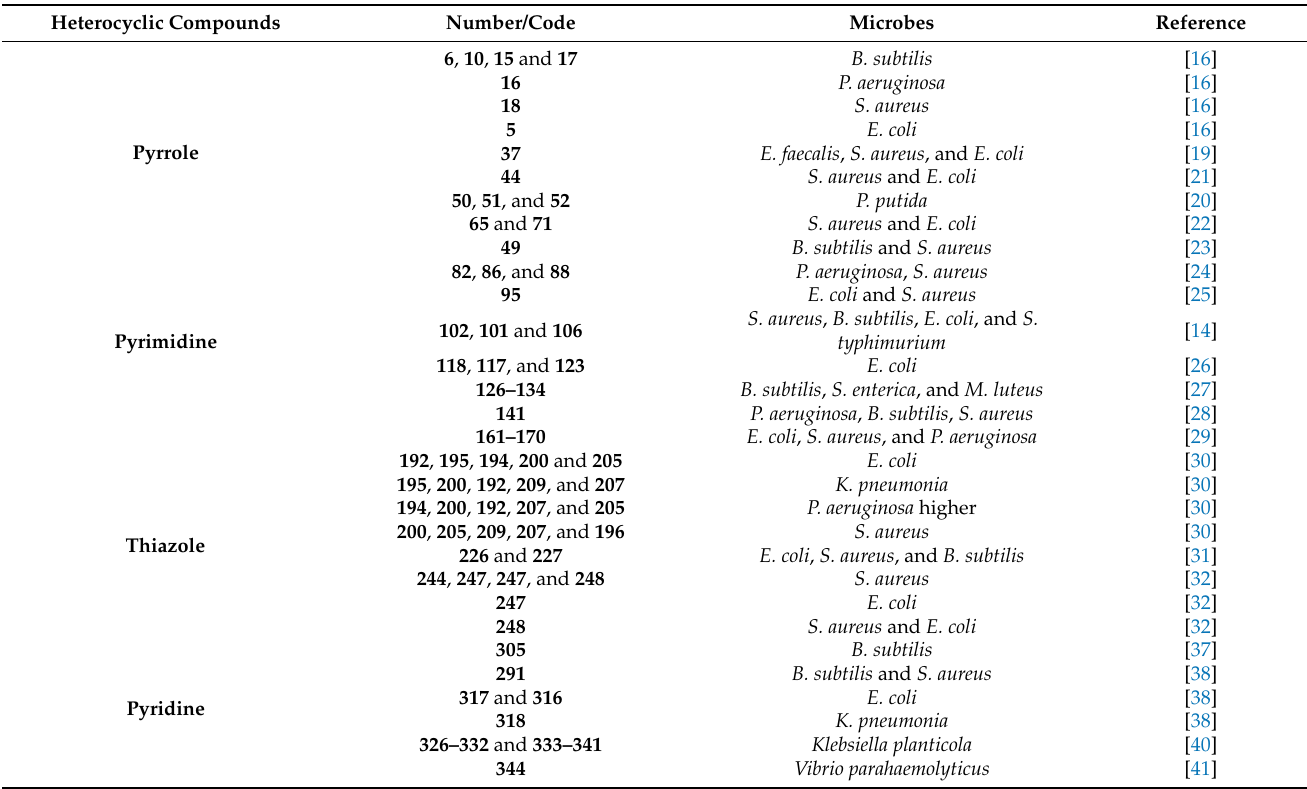
Table 1. Compounds with good antibacterial Table 1 . Compounds with good antibacterial activities.